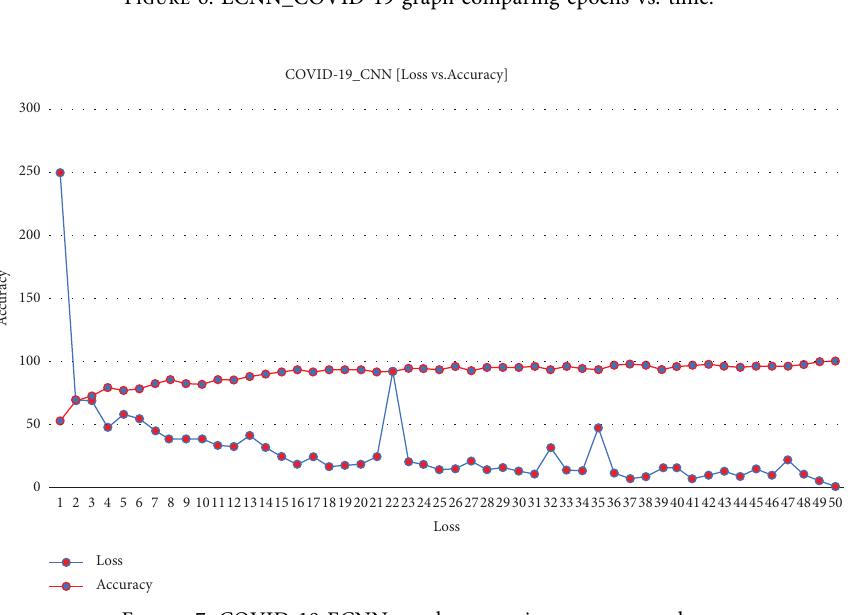
Figure 7: COVID-19 ECNN graph comparing accuracy vs.